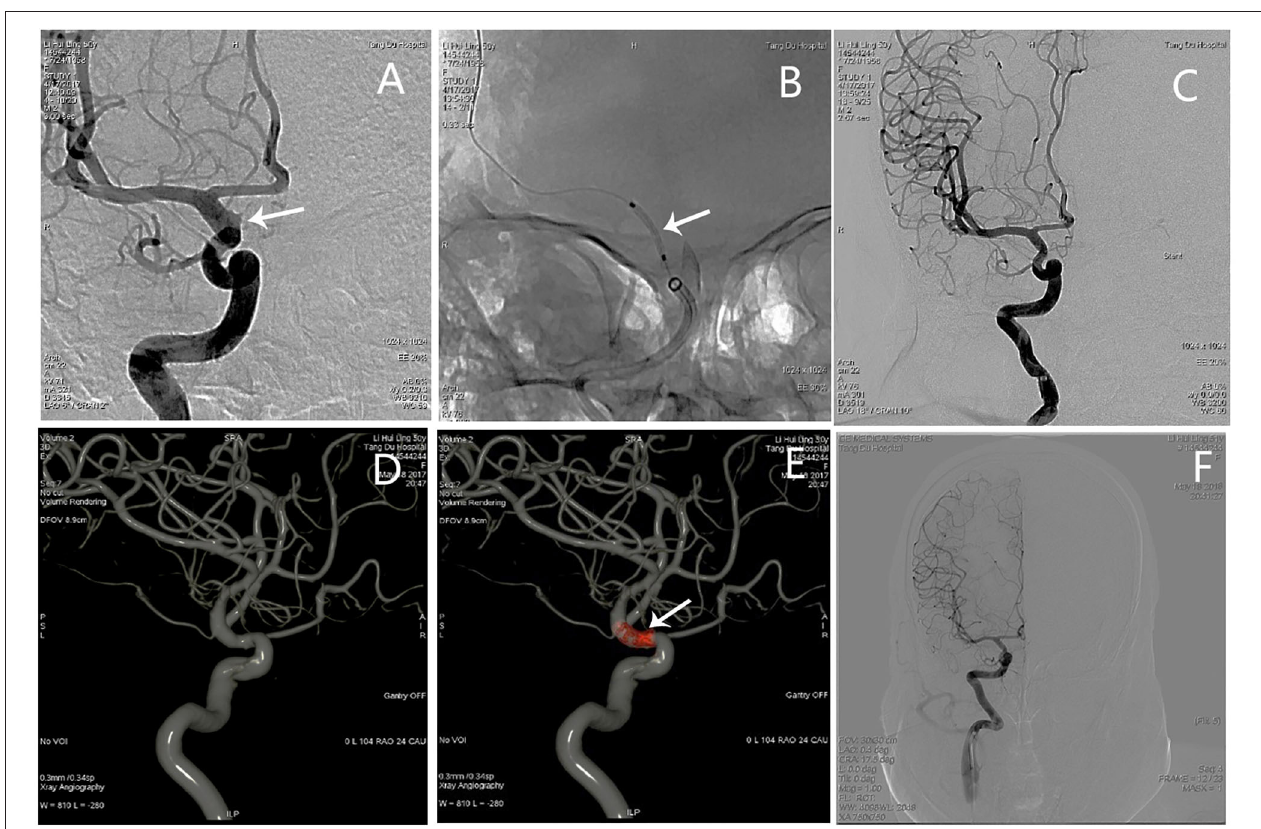
FIGURE 1 | Angiographic images of a 50-year-old woman (see Patient No. 4 in Table 1 ) with a right ICA C6 BBA. (A) A BBA (3.0*1.5mm) located on the anterior wall of the C6 segment. (B) A 3.5*7-mm WCS was deployed (arrow shows). (C) Immediate postoperative angiography showed complete aneurysm occlusion, and the OA and ACHA were not affected. (D) The 3D-DSA showing complete aneurysm occlusion and the parent artery’s morphology. (E) Dual volume technology showing the morphology of the stent and its relationship with the parent artery. (F) Angiography images showing complete aneurysm occlusion at the 13-month follow-up